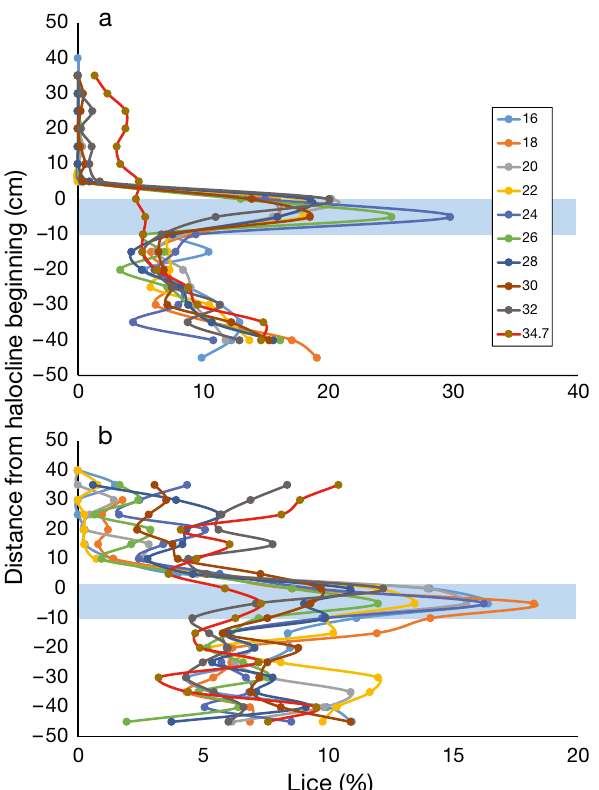
Fig. 3. Average proportion of (a) nauplii and (b) copepodids of salmon lice found in each 5 cm region of the column rela- tive to the step salinity gradient. Colour key shows salinity (ppt) in the top layer for the 10 different treatments. Shaded area = 10 cm over which the largest change in salinity oc- curred. Each point represents the mean of 4 column repli- cates. The 34.7 ppt treatment served as an isohaline control (34.7 ppt in both the top and bottom layers of the column)